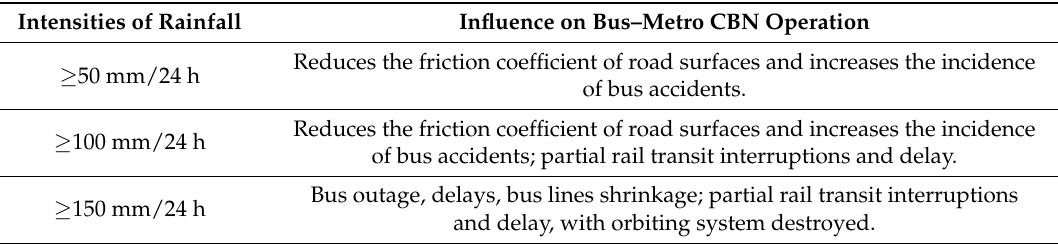
Table 1. The influence of different intensities of rainfall on Bus–Metro CBN [57].